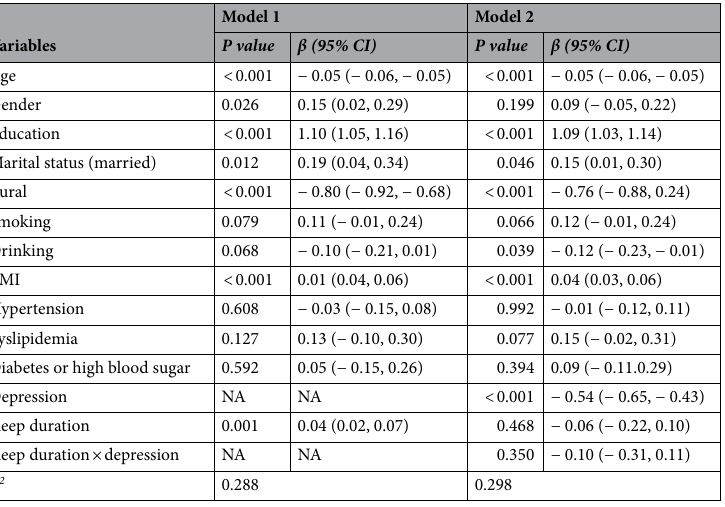
Table 3. Linear regression between depression, sleep duration and cognitive function. BMI body mass index, 95% CI 95% confident interval.